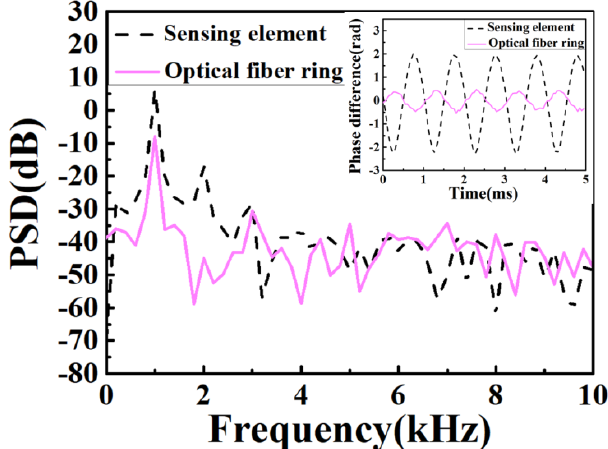
Figure 5. PSD comparison of acoustic detection with the sensing element and the optical fiber ring at 10 Vpp 1000 Hz vibration. (The inset shows the recovered detected acoustic signals).